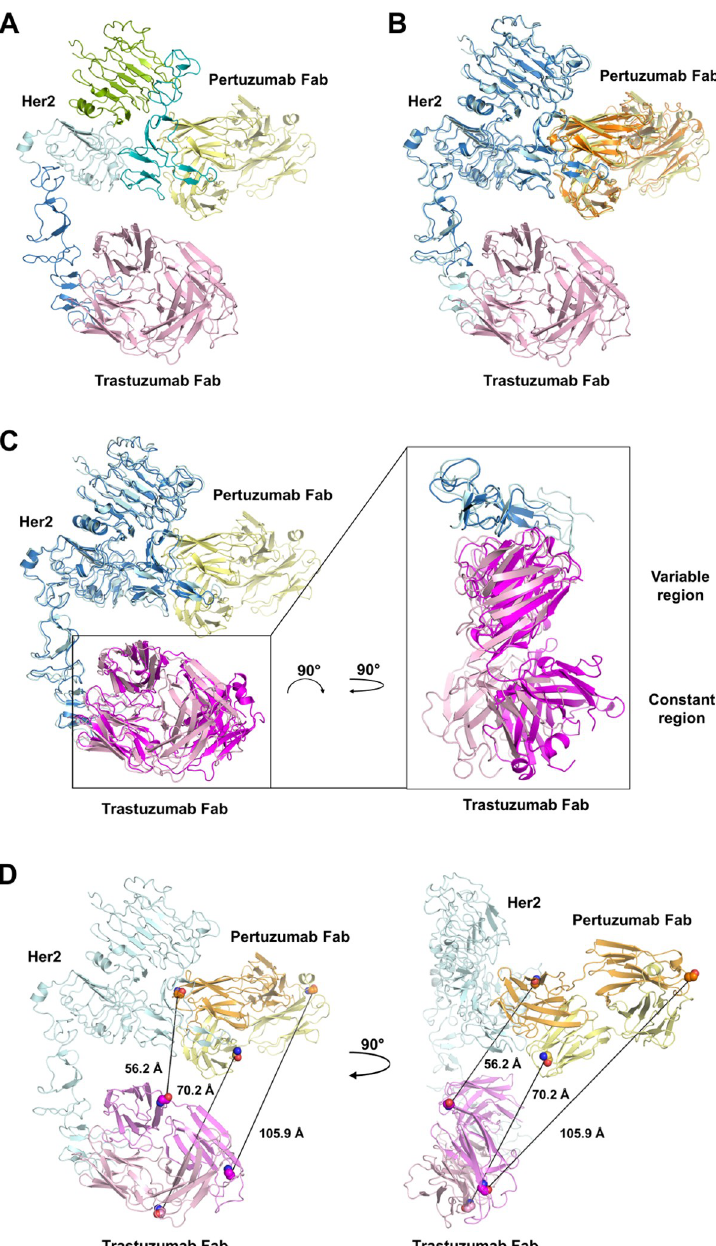
Fig 4. Overall structure of HER2-trastuzumab-pertuzumab and comparison with HER2-pertuzumab (PDB: 1S78) and HER2-trastuzumab (PDB: 1N8Z) structures. A. Overall structure of HER2-trastuzumab-pertuzumab. Domain I through domain IV of HER2 are shown in green, teal, cyan, and blue respectively. Trastuzumab Fab and pertuzumab Fab are shown in pink and yellow respectively. The previously proposed pertuzumab-induced new trastuzumab epitope is highlighted in magenta. B. Structure comparison of HER2-trastuzumab-pertuzumab and HER2-pertuzumab. In HER2-trastuzumab-pertuzumab, HER2, pertuzumab and trastuzumab are shown in cyan, yellow and pink respectively. In HER2-pertuzumab, HER2 and pertuzumab are shown in blue and orange respectively. C. Structure comparison of HER2-trastuzumab-pertuzumab and HER2-trastuzumab. In HER2-trastuzumab-pertuzumab, HER2, trastuzumab and pertuzumab are shown in cyan, pink and yellow respectively. In HER2- trastuzumab, HER2 and trastuzumab are shown in blue and magenta respectively. D. Distances between the C-terminus of trastuzumab V L and N-terminus of pertuzumab V L (68.6 Å ), between C-terminus of trastuzumab V H and N-terminus of pertuzumab V H (56.2 Å ), and between the C-termini of trastuzumab C H 1 and pertuzumab C H 1 (99.7 Å ) were measured. The residues used for measurement are highlighted in spheres. Light chain and heavy chain of trastuzumab Fab are shown in pink